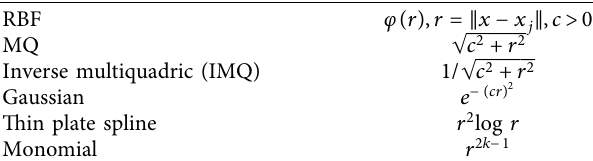
Figure 2: Trajectories of system (7) for a variety of c path symbolizes the trajectory for a variety of speeds c like 0.5 (blue), 2 (red), 3 (yellow), and 4 (purple). Table 1: Definitions of some well-known